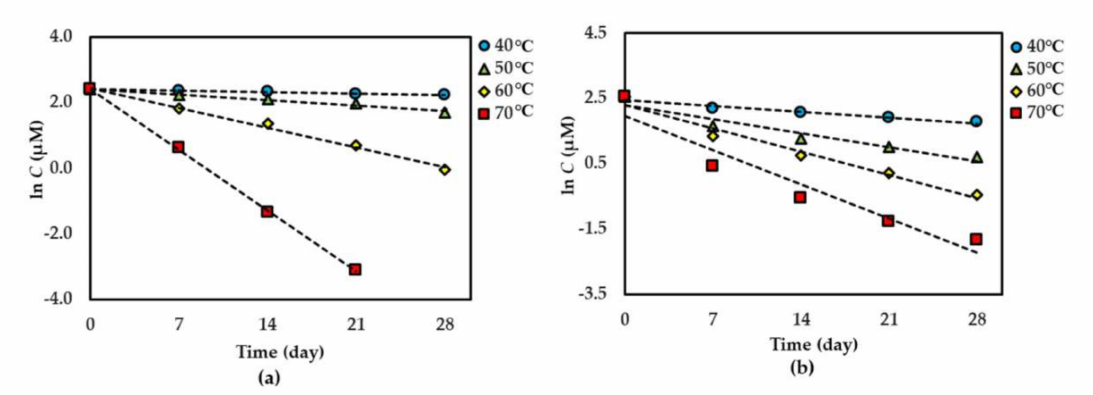
Figure 3. Thermal degradation kinetics for compound 2 in ( a ) dried AE and ( b ) AE solution as fitted to a first-order kinetic model at 40 ◦ C–70 ◦ C for 28 days. The plotted points are mean ± SD ( n = 3).